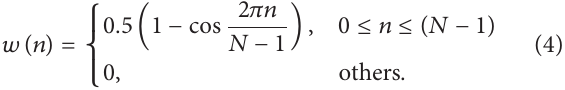
Figure 3: Schematic of an autoencoder.